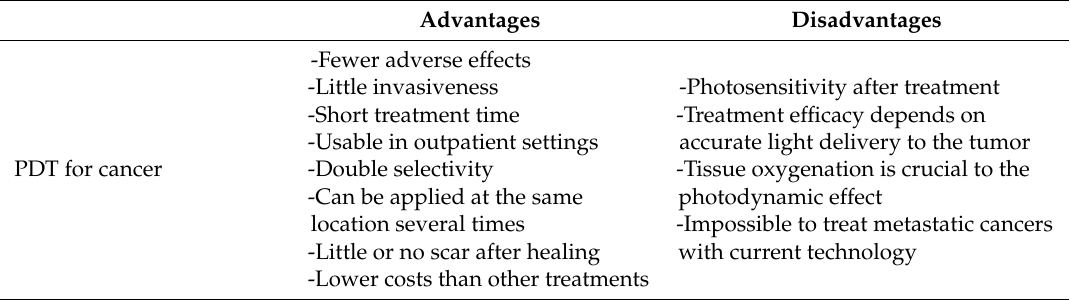
Table 1. Advantages and disadvantages of Photodynamic